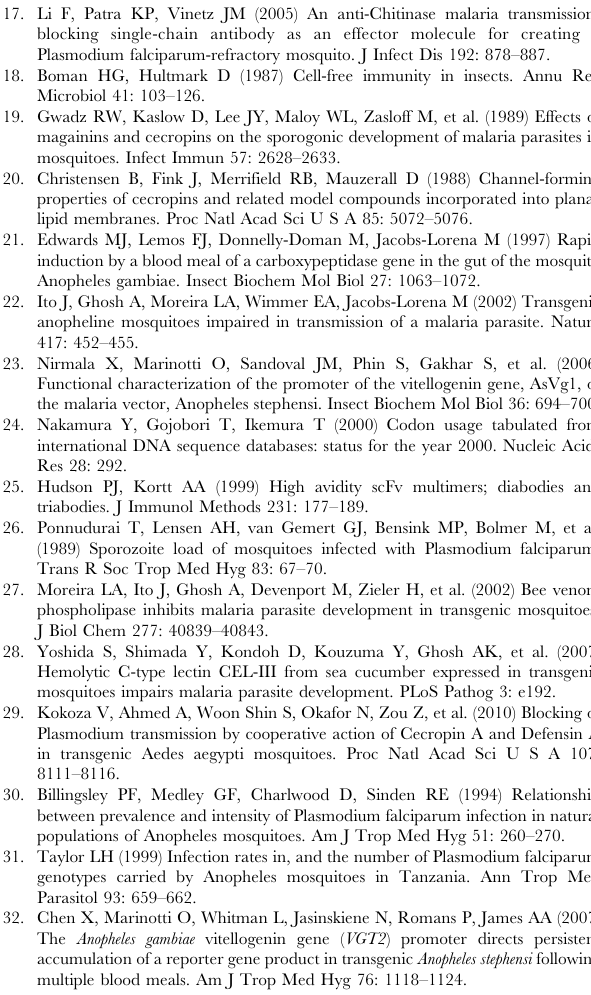
used in the immunblot of non-denatured hemolymph samples (Figure 3C) displayed protein migration. All labeling as in Figure 4. (TIF) Table S1 Comparison of Anopheles gambiae (256,340 codons) and Mus musculus (18,786,705 codons) codon usage for select amino acids [23]. (DOC) Table S2 Transgene-specific primers used in expression